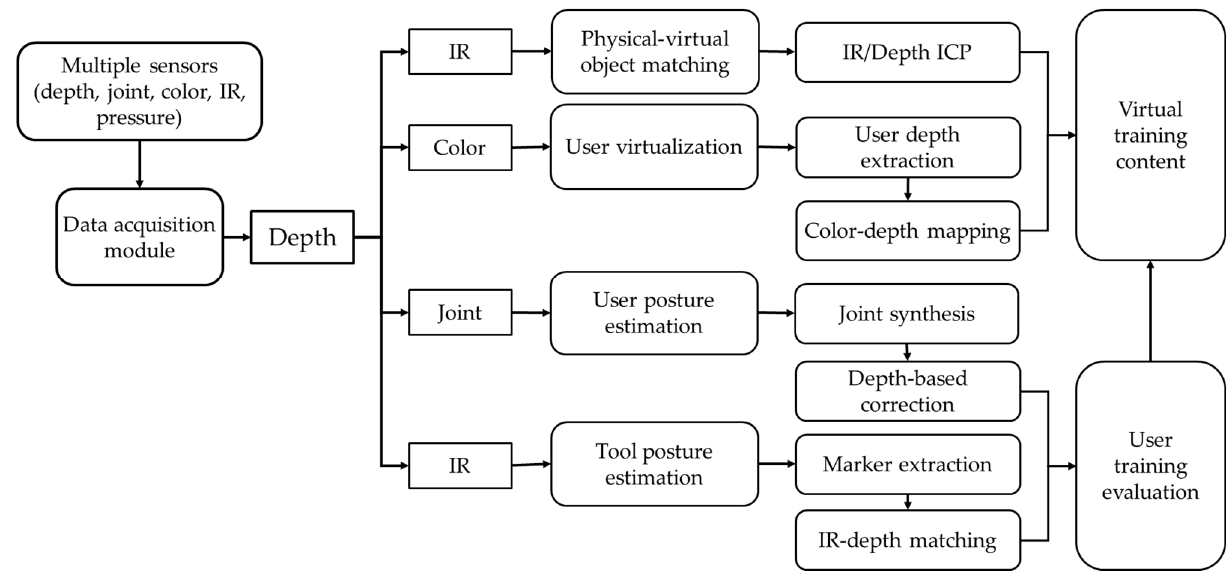
Figure 2. Overview of VR-based job training process.